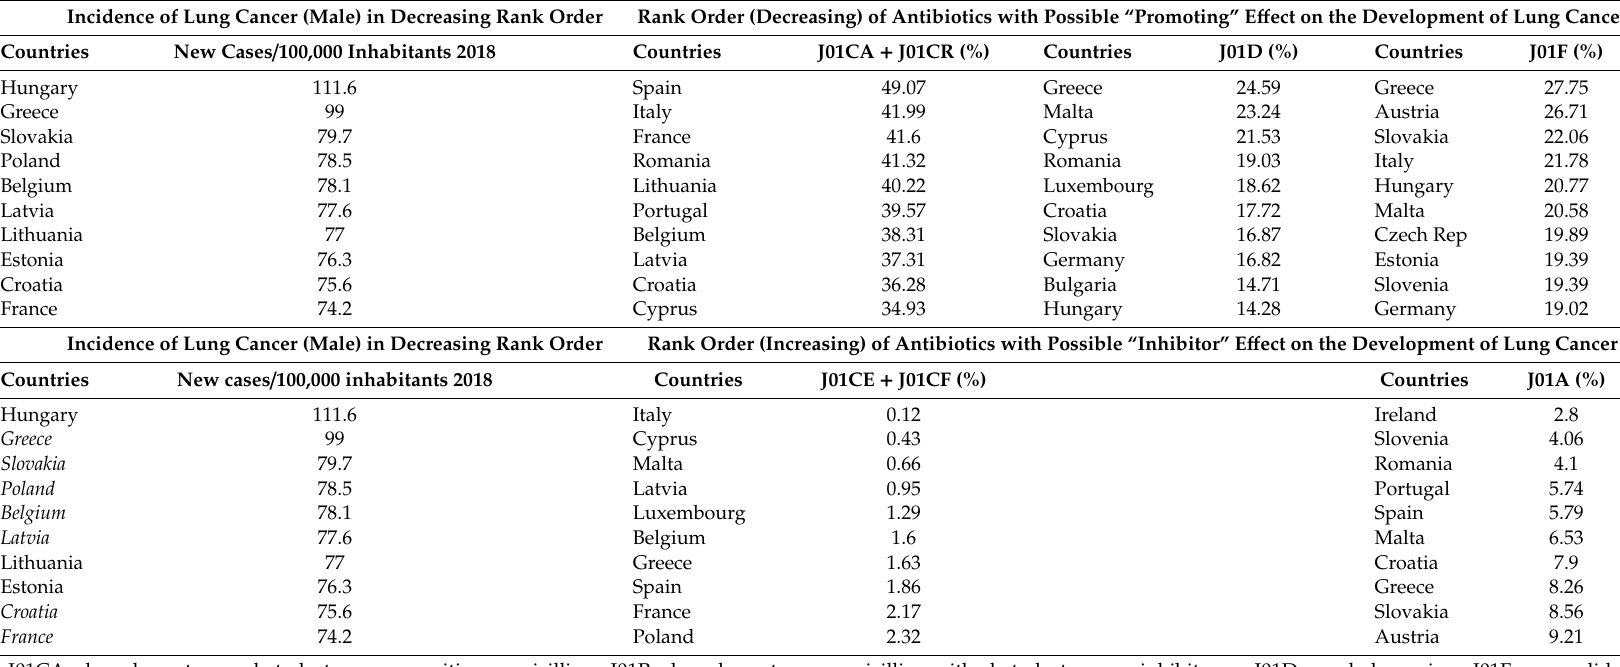
Table 3. Rank order (decreasing) of the incidence of male lung cancer (10 countries) compared to the rank order (decreasing) of antibiotics with suspected “promoter” e ff ect and the increasing (reverse) rank order of the suspected “inhibitor” e ff ect of antibiotics. Of the first ten countries with the highest incidence rate of male lung cancer, nine countries can be found among the highest consumption figures of “promoter” antibiotics (exception: Poland). Seven countries with the lowest consumption figures of “inhibitor” antibiotics, are among the first high incidence rate of male lung cancer (exception: Hungary, Lithuania, Estonia) Incidence of Lung Cancer (Male) in Decreasing Rank Order Rank Order (Decreasing) of Antibiotics with Possible “Promoting” E ff ect on the Development of Lung